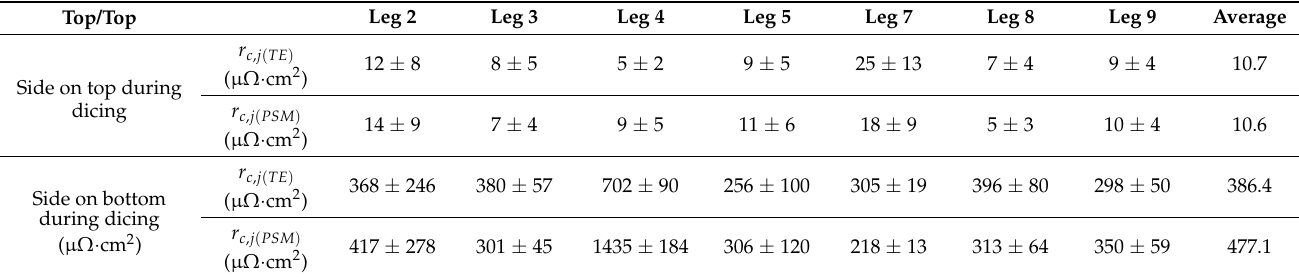
Table 1. Specific electrical contact resistances r c on both sides of several legs, diced from a pellet contacted with Al foils. Leg 6 is missing as it broke during preparation, and leg 1 was cracked, which led to a massive potential drop, therefore the corresponding values are not reported.